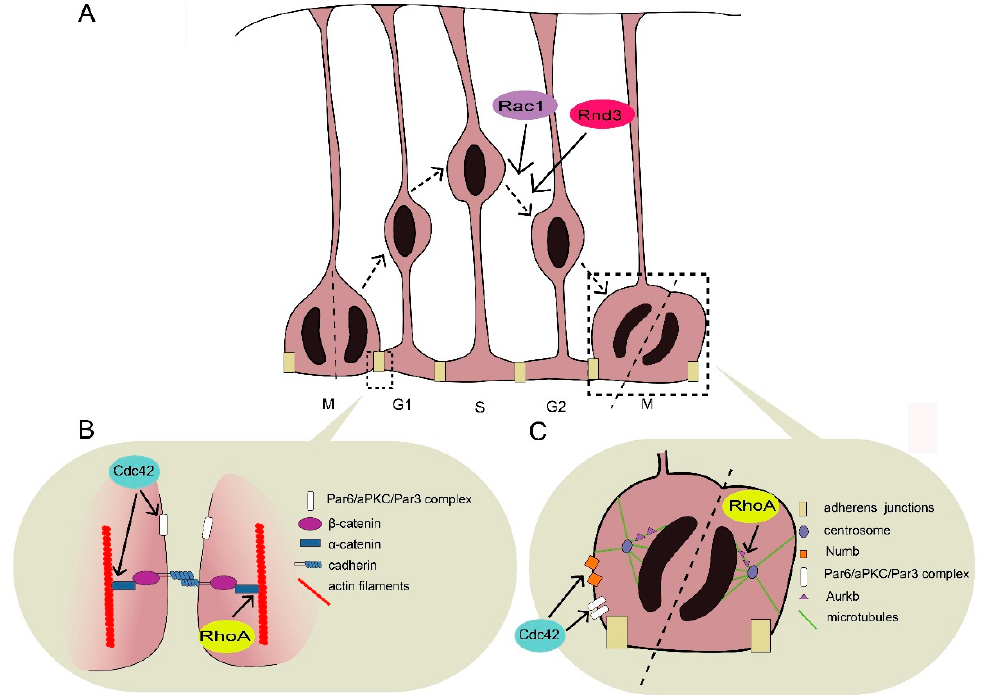
Figure 1. Rho GTPases regulate neurogenesis or interkinetic nuclear migration (INM). ( A ) Radial glial progenitors (RGPs) line the ventricular surface and exhibit apical–basal polarity. The nuclei within RGPs undergo an oscillatory form of cycle-dependent migration, which leads to symmetric